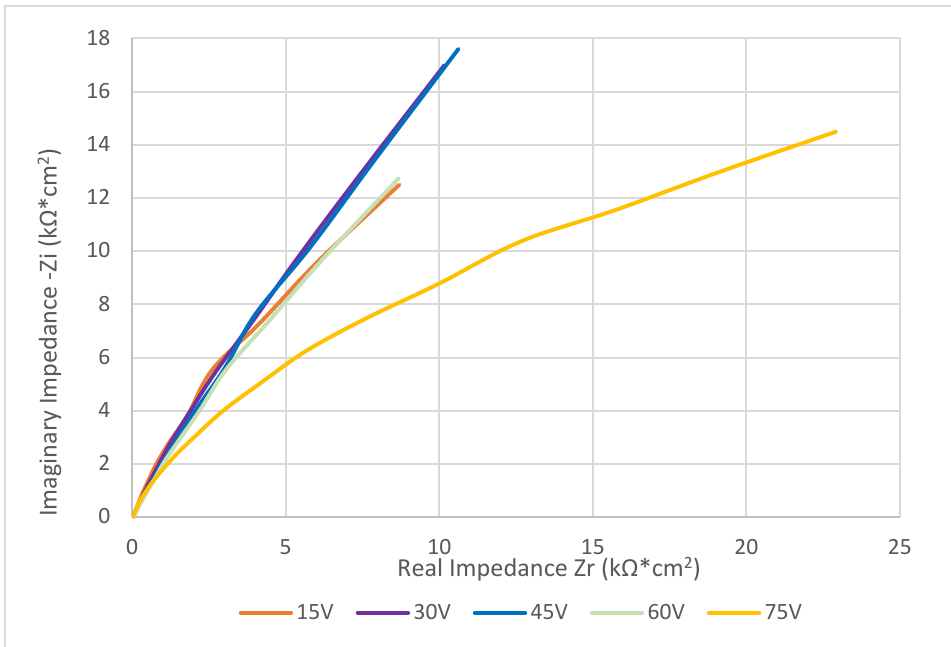
Figure 5. Nyquist diagram for surfaces anodized at different voltages. EIS specters were fitted with an equivalent circuit by EIS Spectra Analyser 1.0 and parameters of each element were obtained. Parameter values for different anodization voltages are listed in Table 3. Resistance of all the circuit connectors and corrosion solution itself are summarized as a value of “Resistance solution” (R solution) [25]. Resistance of